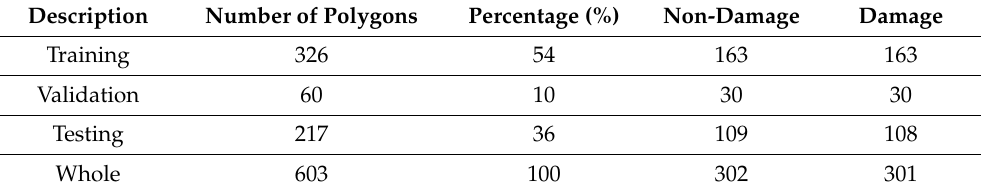
Table 1. Details of the sample dataset only fusing for building damage mapping (unit is polygon).